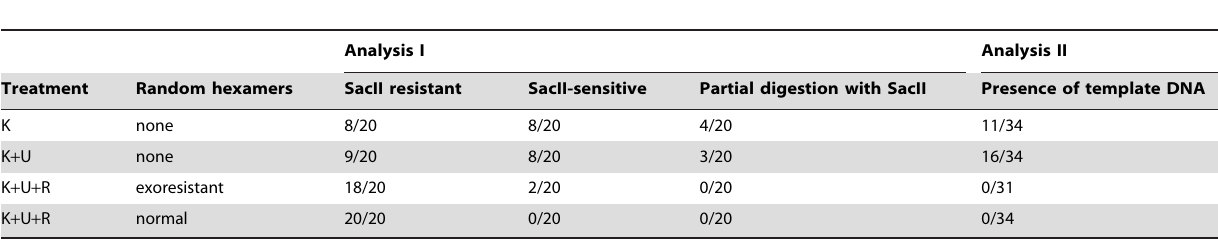
Table 2. Colony PCR screen of clones created with primer extension mutagenesis of CDR-H3 loop.